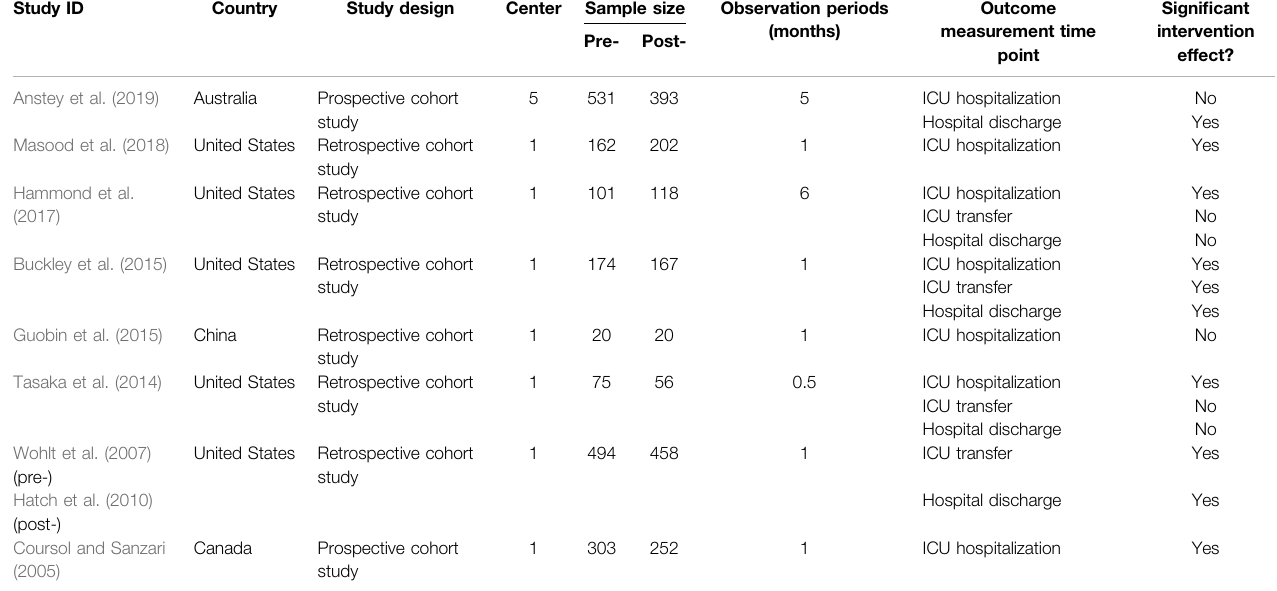
TABLE 1 | Characteristics of included